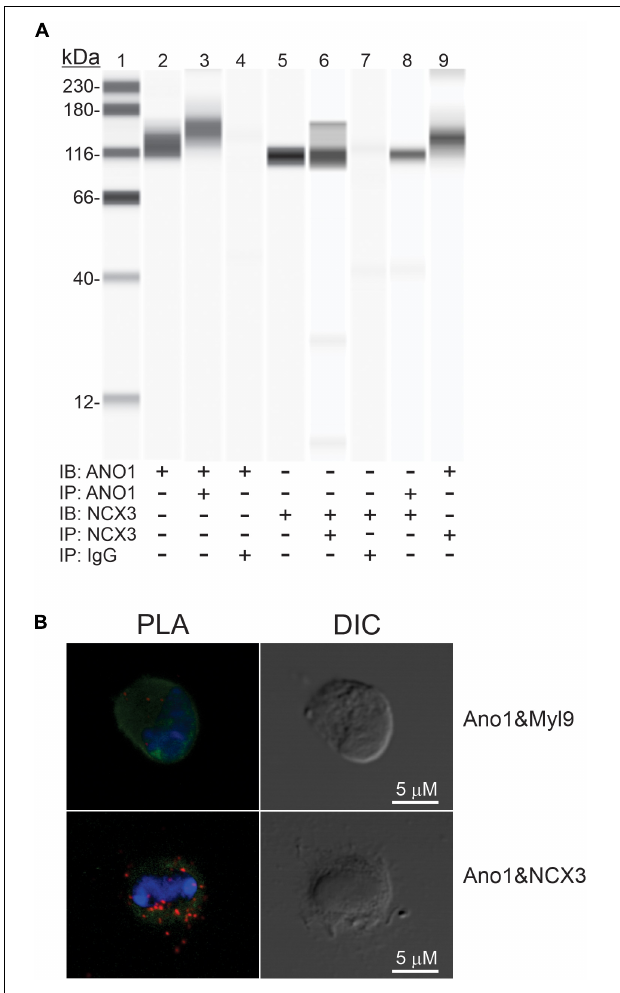
FIGURE 11 | Protein-protein interaction between ANO1 and NCX3. (A) Co- IP of ANO1 and NCX3 from small intestine smooth muscle membrane fraction. Immunoprecipitates (IP) were obtained by elution with low pH buffer, and immunoblotting (IB) was performed using Wes with anti-ANO1 and anti-NCX3 antibodies. Lanes: 1, protein standards; 2, ANO1 in membrane fraction (2.5 mg); 3, ANO1 in ANO1 immunoprecipitate (5 ml); 4, ANO1 in non-immune rabbit IgG IP; 5, NCX3 in membrane fraction (1 mg); 6, NCX3 in NCX3 immunoprecipitate (5 ml); 7, NCX3 in non-immune rabbit IgG IP; 8, NCX3 in Ano1 immunoprecipitate (5 ml); 9, ANO1 in NCX3 immunoprecipitate (5 ml) n = 4. (B) Association between ANO1 and NCX3 occurs in situ in ICC, as demonstrated by PLA. ICC from small intestine (green, left panel) were exposed to the rabbit anti-ANO1 and goat anti-NCX3 antibodies, followed by the Duolink minus-anti rabbit IgG and plus-anti goat IgG secondary antibodies and the ligation and amplification reactions. For the PLA negative control, ICC were exposed to rabbit anti-ANO1 and mouse anti-myosin regulatory light chain antibodies (upper left panel). PLA-positive red spots were detected by ANO1-NCX3 co-localization (lower left panel). Few red spots were observed in negative controls. Nuclear staining of ICC was achieved with DAPI (blue, left panel). Intact ICC were confirmed by differential interference contrast (DIC) (right